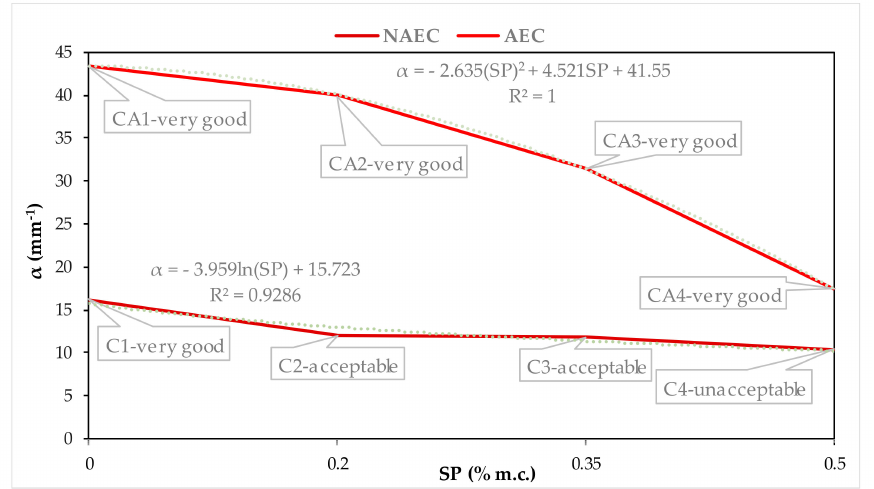
Figure 5. Dependences between A and SP contents in NAEC and AEC.